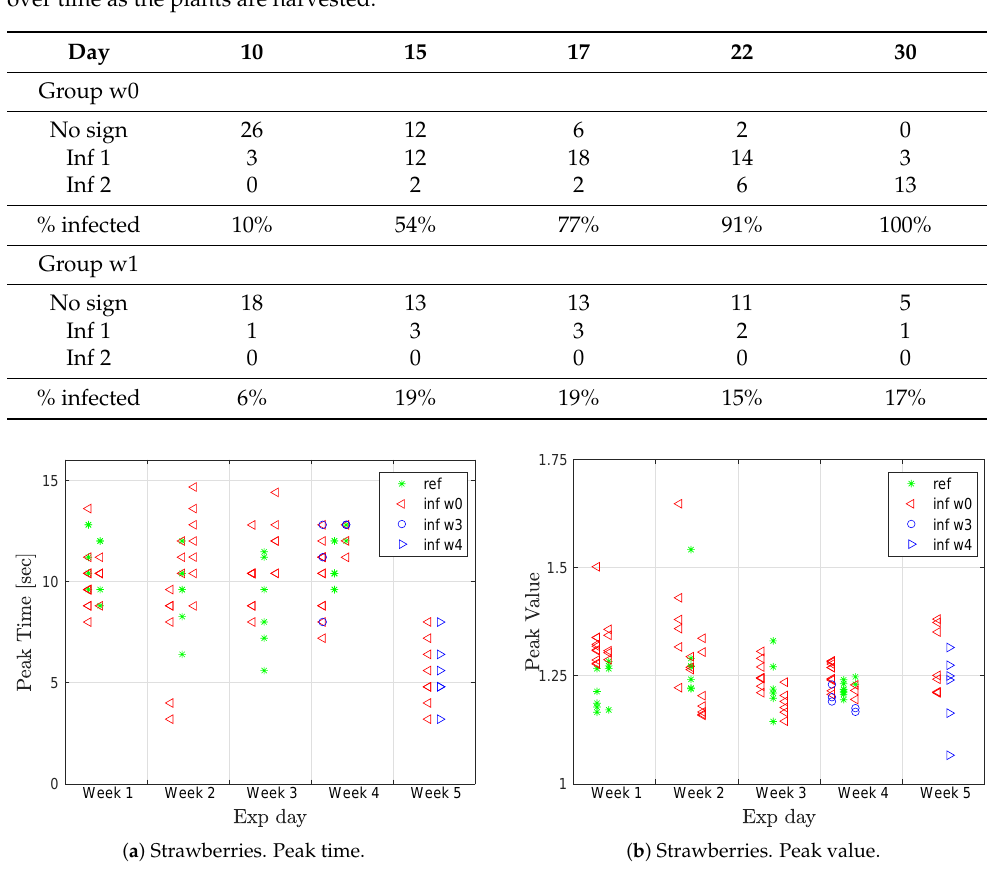
Figure 11. Fluorescence step response ( a ) peak time and ( b ) peak value for powdery mildew infected strawberries at the lowest background light level. ref: healthy plants, inf w0: infected week 0, i.e., 4 days prior to first measurement, inf w3/4: measured as reference weeks 3/4, after being placed in the infected unit but with no visual symptoms. Table 5. Powdery mildew experiment. Peak values at the first background light level, for ref and infected plants at week 1 and week